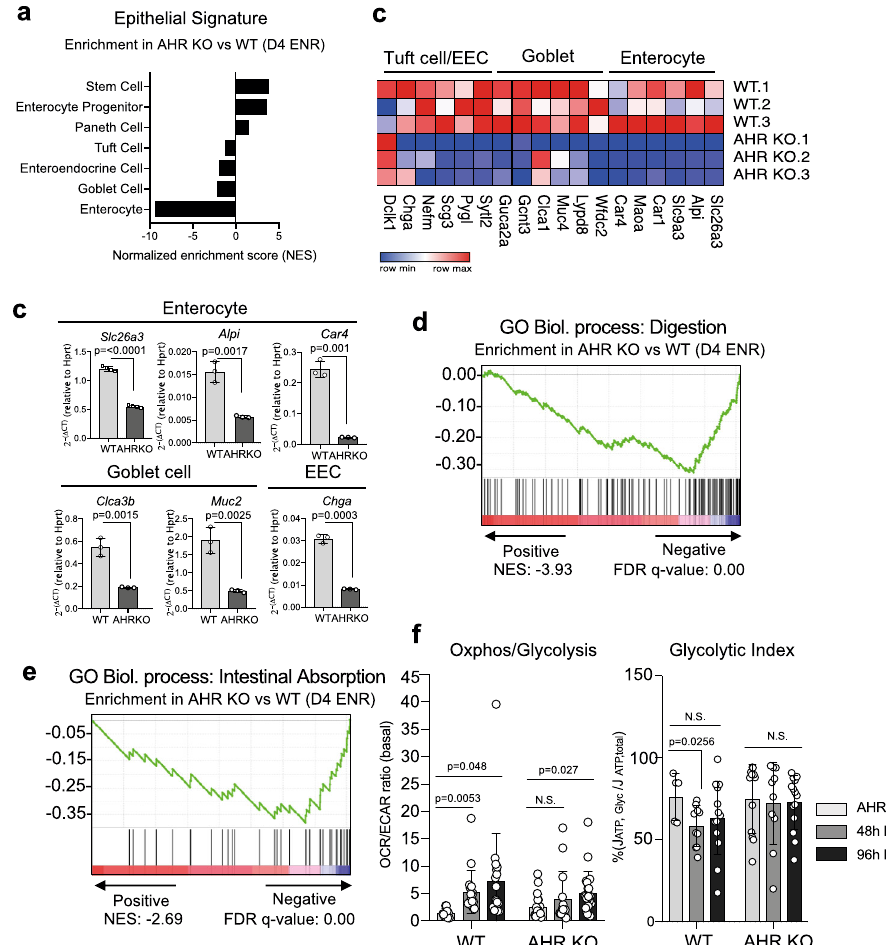
Fig. 5 Loss of AHR impairs colonic epithelial differentiation. a Enrichment plot for transcriptional signature of d4 ENR AHR KO organoids compared to transcriptional signatures from intestinal epithelial cell subtypes. b Heatmap showing expression of select genes for mature epithelial subsets in either WT or AHR KO cells grown in d4 ENR conditions ( c ) qPCR expression data of mature epithelial markers for colonocytes ( Slc26a3, Alpi, Car4 ), goblet cells ( Clca3b, Muc2 ) or enteroendocrine cells ( Chga ) in d4 ENR WT or AHR KO cells. Organoids used for experiments in ( c ) were generated from either n = 3 bars displayed on graphs represent the mean ± SD of at least three independent experiments. d GO gene ontology analysis for transcriptional signature associated with mature epithelial function such as digestion (NES: − 3.93, FDR q value: 0.00) and ( e ) absorption (NES: − 2.21, FDR q-value: 0.00). f Metabolic analysis by Seahorse of AHR KO organoids compared with WT controls for basal OxPHOS vs glycolysis (left panel) and glycolytic index (right panel) and assessed at either 0 h (WENR conditions), 48 h (d2 ENR) and 96 h (d4 ENR) post-Wnt removal. Data shows mean ± SD expression of technical replicates from organoids generated from n = 3 mice and data pooled from three independent experiments. Multiple t -tests was performed between each timepoint vs WENR condition per genotype to determine statistical signi fi cance. Source data for (5 c , f ) are provided with this paper in the source data fi